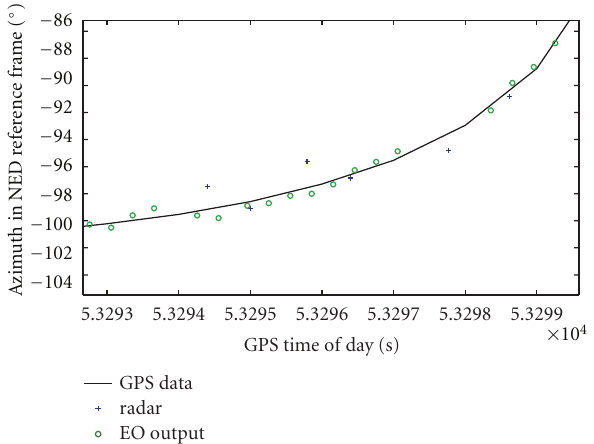
Figure 13: Comparison of intruder elevation in NED reference frame among radar, EO, and the postprocessing of GPS data output that is used as